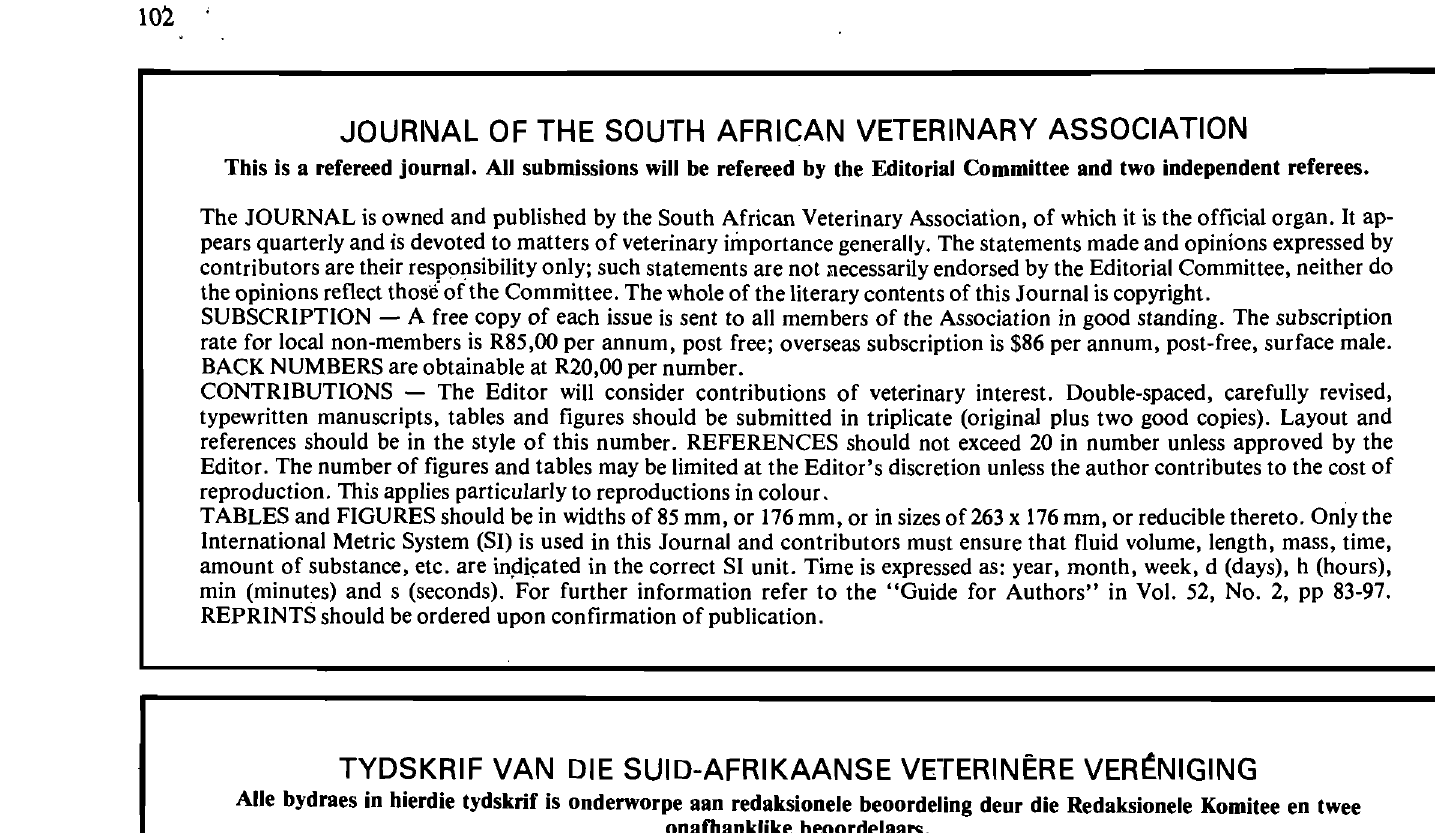
TYDSKRIF VAN DIE SUID-AFRIKAANSE VETERINERE VER~NIGING Aile bydraes in hierdie tydskrif is onderworpe aan redaksionele beoordeling deur die Redaksionele Komitee en twee onafhanklike beoordelaars. Die TYDSKRIF is die offisiele mondstuk en eiendom van en word gepubliseer deur die Suid-Afrikaanse Veterinere Verenig ing. Dit verskyn kwartaalliks en word aan sake van algemene veeartsenykundige belang gewy. Bydraers tot hierdie Tydskrif maak hul stellings en Jug hul menings uitsJuitJik op eie verantwoordelikheid; sodanige stellings word nie noodwendig deur die Redaksiekomitee onderskryf nie en die menings gee nie noodwendig die Komitee se menings weer nie. Kopiereg word op al die letterkundige inhoud van die Tydskrif voorbehou. INTEKENING - 'n Eksemplaar van elke uitgawe word gratis aan aIle volwaardige lede van die Vereniging gestuur. Die in tekengeld vir plaaslike persone wat nie lede is nie, beloop R85,OO jaarliks, posvry; oorsese intekengeld is $86 jaarliks posvry per hand of seepos. VORIGE UITGA WES is beskikbaar.teen R20,OO per eksemplaar. BYDRAES - Die redaksie sal aIle bydraes van veeartsenykundige belang vir publikasie oorweeg. Dubbelgespasieerde, nou keurig hersiende, getikte manuskripte en meegaande figure en tabelle moet in triplikaat (oorspronklike en twee goeie af skrifte) ingedien word. Opset en verwysing moet die styl van hierdie uitgawe volg. MEER AS 20 VERWYSINGS word slegs met die goedkeuring van die Redakteur toegelaat. TABELLE en FIGURE moet in breedtes van 85 mm, of 176 mm, of in groottes van 263 x 176 mm weergegee word, of daartoe gereduseer kan word. Die getaJ figure en tabelle kan na oordeel van die redaksie beperk word tensy die outeur tot die koste van reproduksie bydrae, veral kleurreproduksie. Slegs die Internasionale Metrieke Stelsel (SI) word in hierdie Tydskrif gebruik, en outeurs moet sorg dat die korrekte SI eenhede vir vloeistofvolume, lengte, massa, tyd en stofhoeveelheid gebruik word. Tyd word uitgedruk as: jaar, maand, week, d (dae), h (ure), min (minute) en s (sekondes). Verwys verder na die "Riglyne vir Outeurs" in Jaargang 52, Nr 2, pp 83-97. HERDRUKKE moet ten tye van bevestiging van plasing bestel